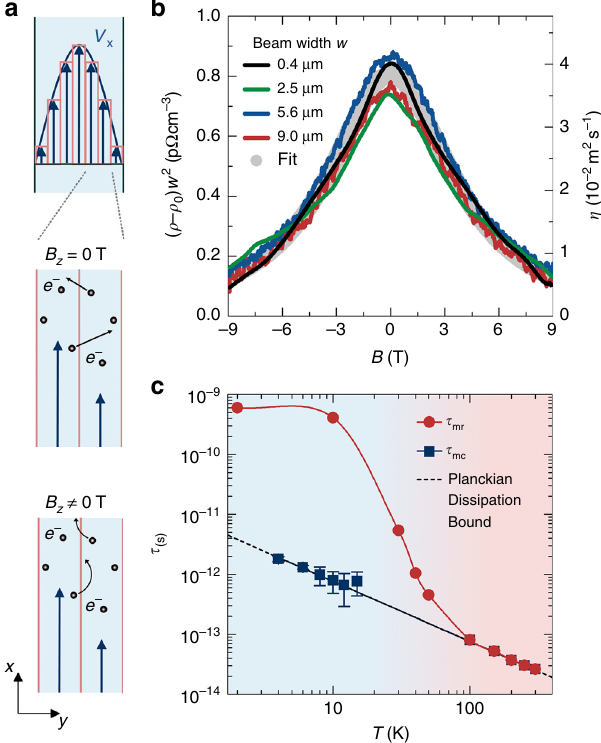
Fig. 3 Magnetohydrodynamics and the Planckian bound of dissipation. a The origin of the decrease of the electron viscosity η in a magnetic fi eld B (schematic) perpendicular to the current fl ow ( B = B z ) and the sample width. The viscous friction between two adjacent layers of the electron fl uid moving (the arrows point along the fl ow direction) with different velocities (length of the arrows) is determined by the depth of the interlayer penetration of the charge carriers e − (black dots). In a magnetic fi eld, this depth is limited by the cyclotron radius. b ( ρ − ρ 0 )/ w 2 as a function of B for all four WP 2 ribbons investigated at 4 K (lines), where ρ 0 is the electrical resistance in zero fi eld. The experimental data have been fi tted by the magnetohydrodynamic model in the Navier – Stokes fl ow limit (gray dots). c Experimentally extracted momentum-relaxing and momentum- conserving relaxation times τ mr and τ mc , respectively (symbols, with guide to the eye). The error bars denote the errors of the fi ts exemplarily displayed for 4 K in a (see Supplementary Information for details). The dashed line marks the Planckian bound on the dissipation time τ ℏ = ℏ /( k B T